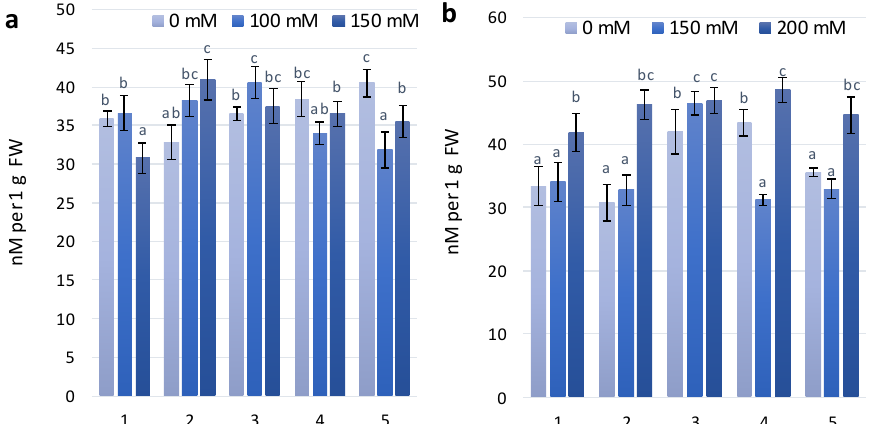
Figure 5. MDA content in wheat leaves under effect of different NaCl concentrations ( a )—first stage of treatment; ( b )—second stage of treatment. Wheat genotypes: 1—Citrus yellow, 2—KM 53-14 Blue, 3—KM 178-14 purple, 4—Skorpion Blue aleurone, 5—PS Karkulka purple. The columns represent the mean values ± S.E. for six replicates. Statistically significant differences among treatments at each time are indicated by different small letters (Duncan test, p <